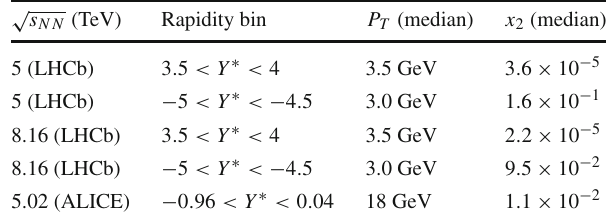
Table1 Thevaluesforthecenter-of-massenergy,rapiditybins,median of P T , and x 2 for D -meson production in the kinematic features pro- vided by the LHCb and ALICE measurements √ s NN